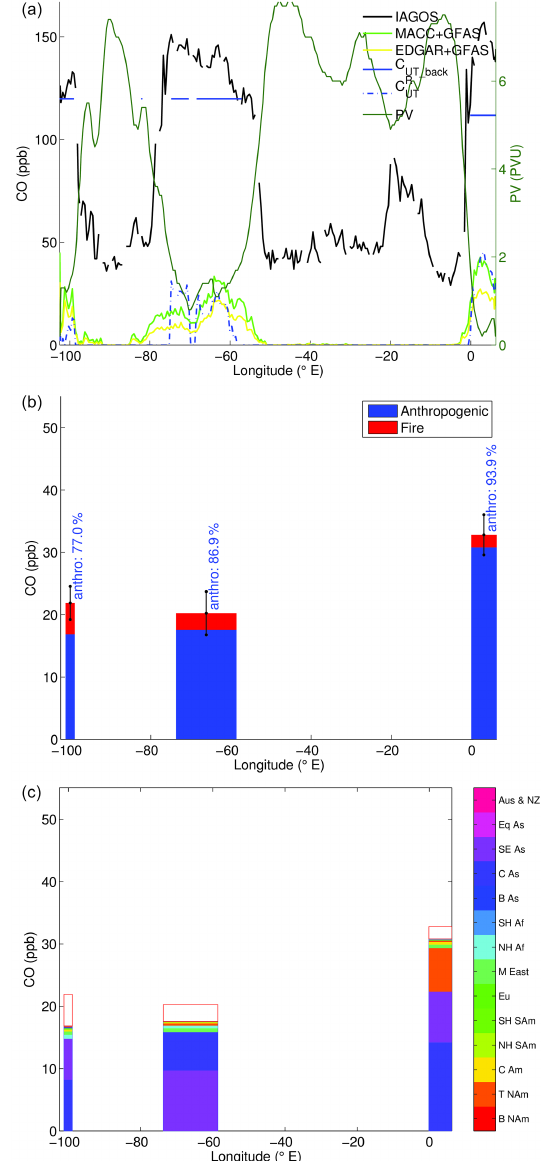
Figure 5. (a) Carbon monoxide profiles over Hong Kong during a MOZAIC–IAGOS flight landing on 22 October 2005. The black line indicates the observed CO profile while the blue line indicates the CO background deduced from the observations. Green and yel- low lines indicate the simulated CO contributions using, respec- tively, MACCity and EDGARv4.2 for anthropogenic emissions and using GFAS v1.2 for biomass burning emissions. Simulated CO is separated into (b) source contribution (anthropogenic in blue, fires in red, standard deviation in black) and (c) regional anthro- pogenic origins (14 regions defined for global emission inventory, http://www.globalfiredata.org/data.html, see Fig. S1 in the Supple- ment; unshaded red square is for fire contribution), using MACCity and GFAS v1.2.